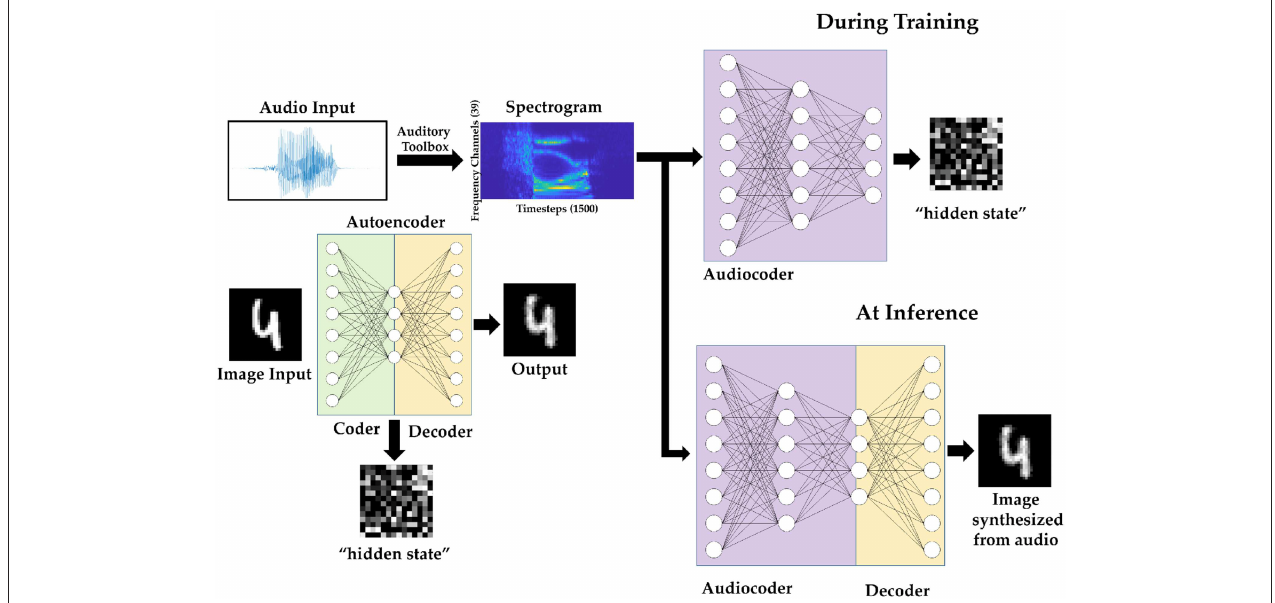
FIGURE 8 | Audio to image synthesis model using an autoencoder trained on MNIST images, and an Audiocoder trained to convert TI-46 digits audio samples into corresponding hidden state of the MNIST images.